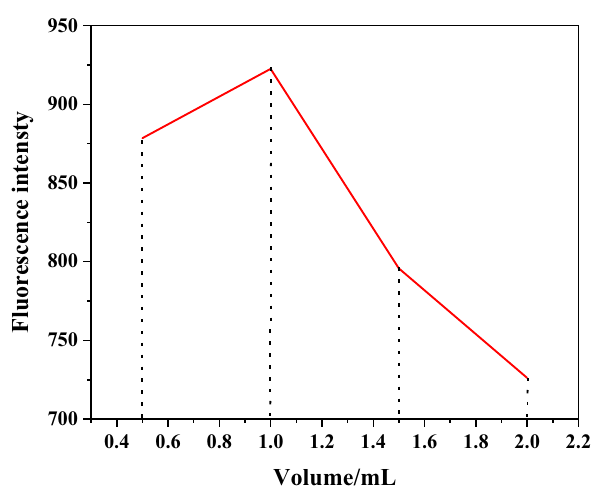
Figure 5: E ff ect of dosage of Bpy on maximum fl uorescence intensity of system.